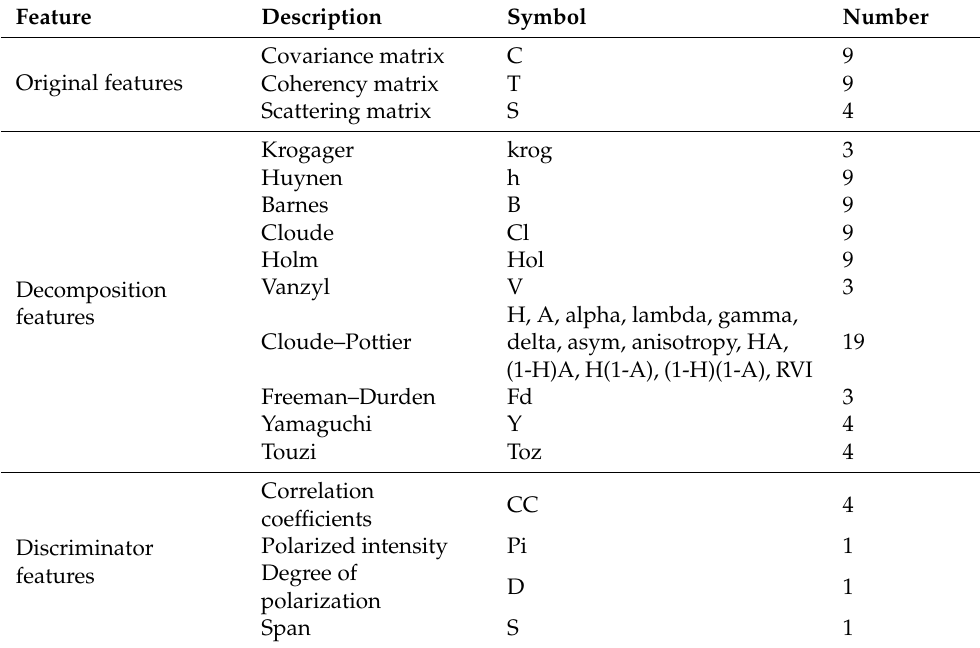
Table 2. Features extracted from the SAR